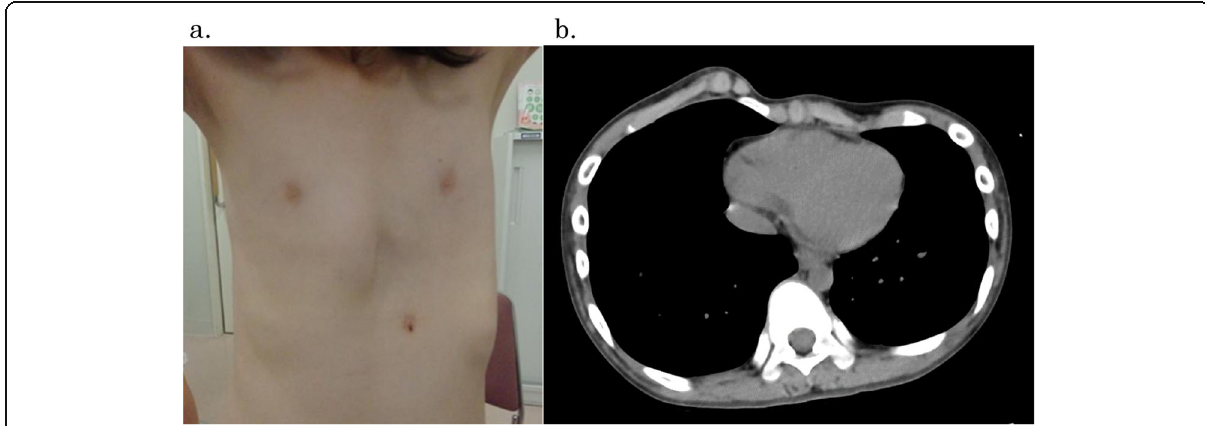
Fig. 1 a Appearance. Asymmetric pectus excavatum can be observed. b Preoperative computed tomographic scan of the chest. Computed tomographic scan shows pectus excavatum